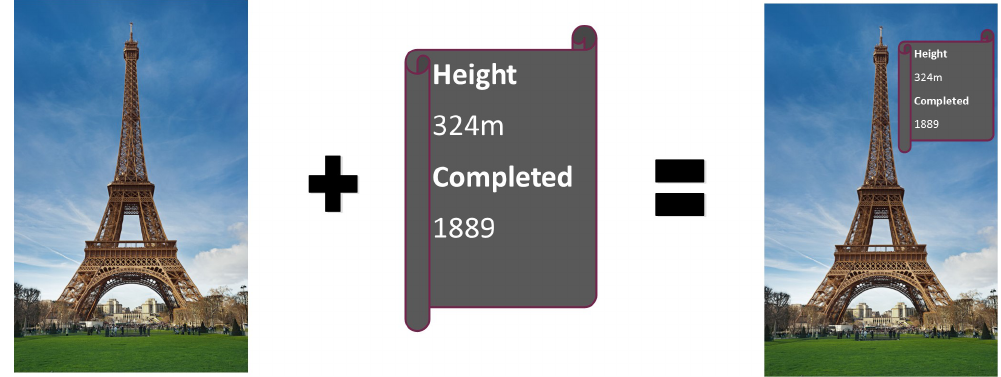
Figure 1. Augmented Reality (AR) scenario example for tourism: Eiffel Tower AR.